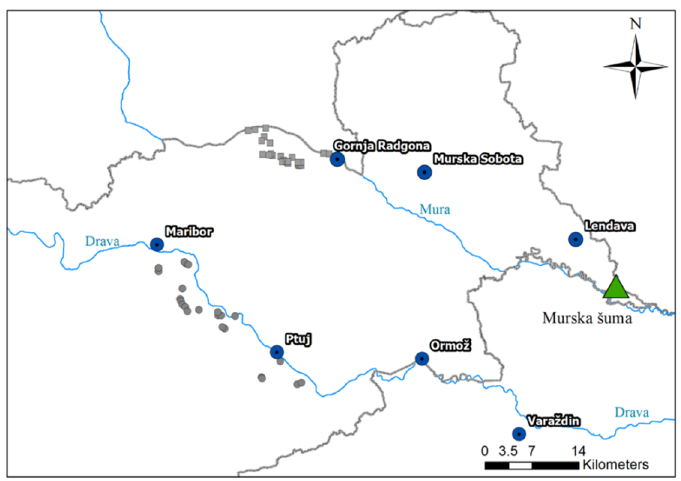
Figure 5. Map indicating the study area in the NE part of Slovenia, Europe. In detail, the distribution of forest fragments in studied areas is indicated: Apaško polje (grey squares) and Dravsko polje (grey dots). The control of the unfragmented forest area of Murska šuma is indicated by the green triangle.